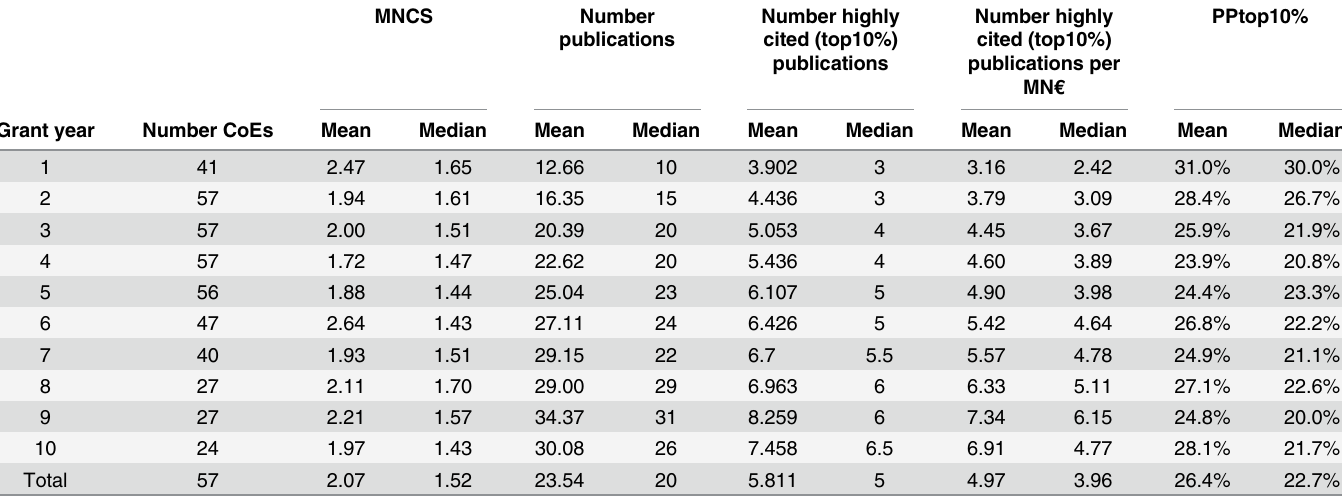
Table 1. Developments in annual measures of citation impact and productivity over time for